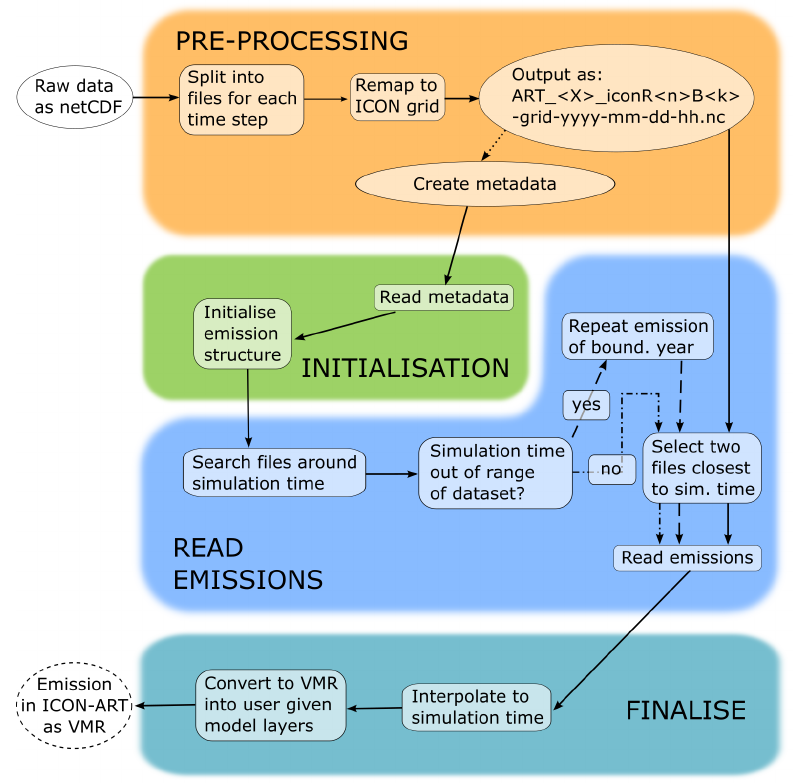
Figure 2. Flow chart of the process from the external netCDF emission data with regular grid and emission data as mass flux density to the emission as VMR in ICON-ART. The process can be separated into four steps: pre-processing, initialisation, read emissions and finalising the module. Pre-processing before the run of ICON-ART is necessary, whereas the other processes are included in ICON-ART. Ellipses depict files while rectangles stand for processes. The different arrow lines illustrate either the interaction with the remapped netCDF data set which has to be performed by the user in the pre-processing step (dotted), the “no” path (dotted and dashed) or the “yes” path